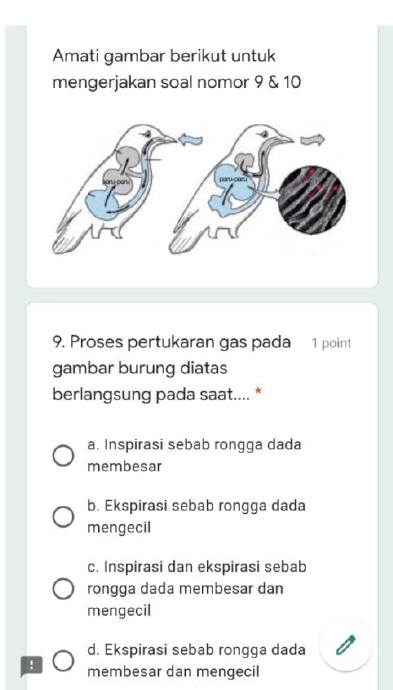
Figure 11. Logic and reasoning question number 9, Package